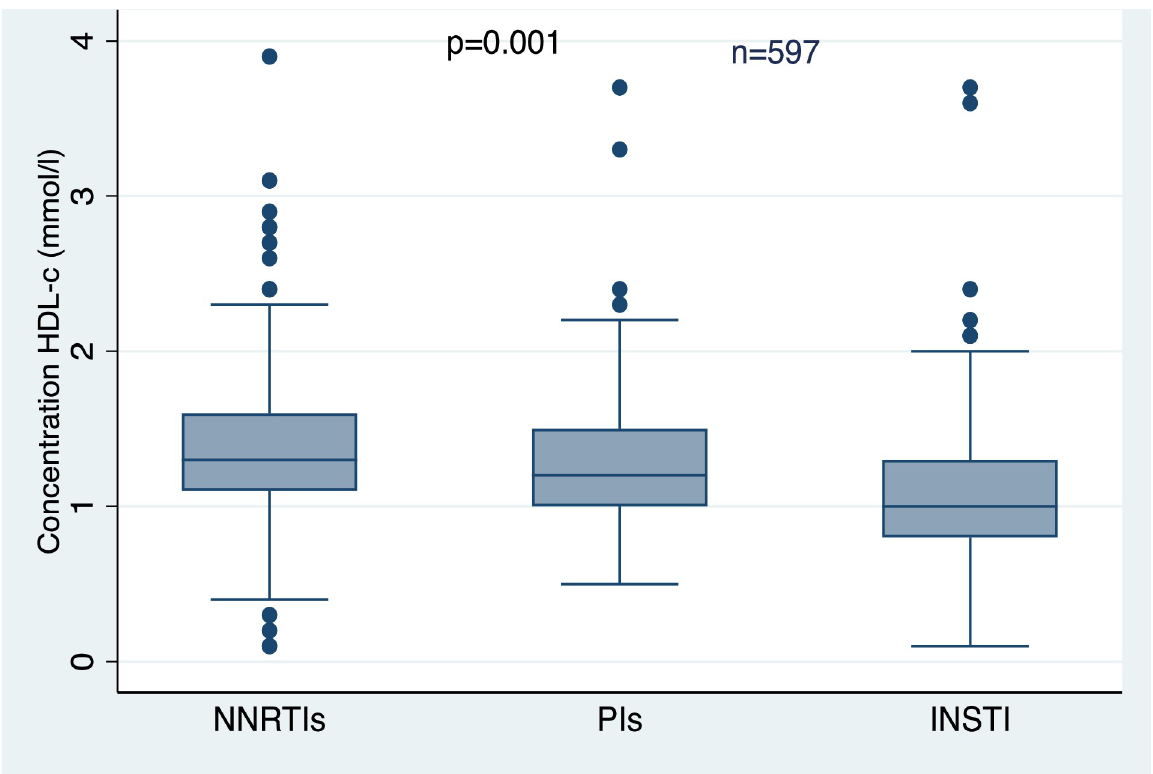
Fig 1. The medians of HDL-c in different ART regimens among all the